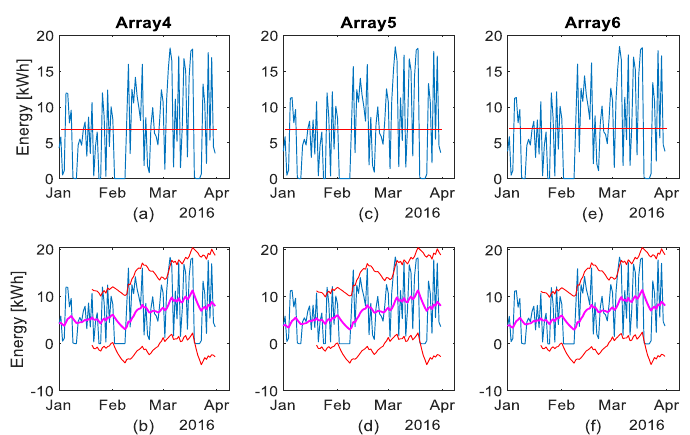
Figure 4. ( a ) Energy produced by array #4 in three months and its mean value as red line; ( b ) upper and lower BB 20 of array #4 in red color, and EMA 20 in magenta color. ( c ) and ( d ) refer to array #5. ( e ) and lower BB 20 of array #4 in red color, and EMA 20 in magenta color. ( c , d ) refer to array #5. ( e , f ) refer and ( f ) refer to array #6. to array Table 1. Mean energy and spread with respect to the global mean for the quarter analysis.